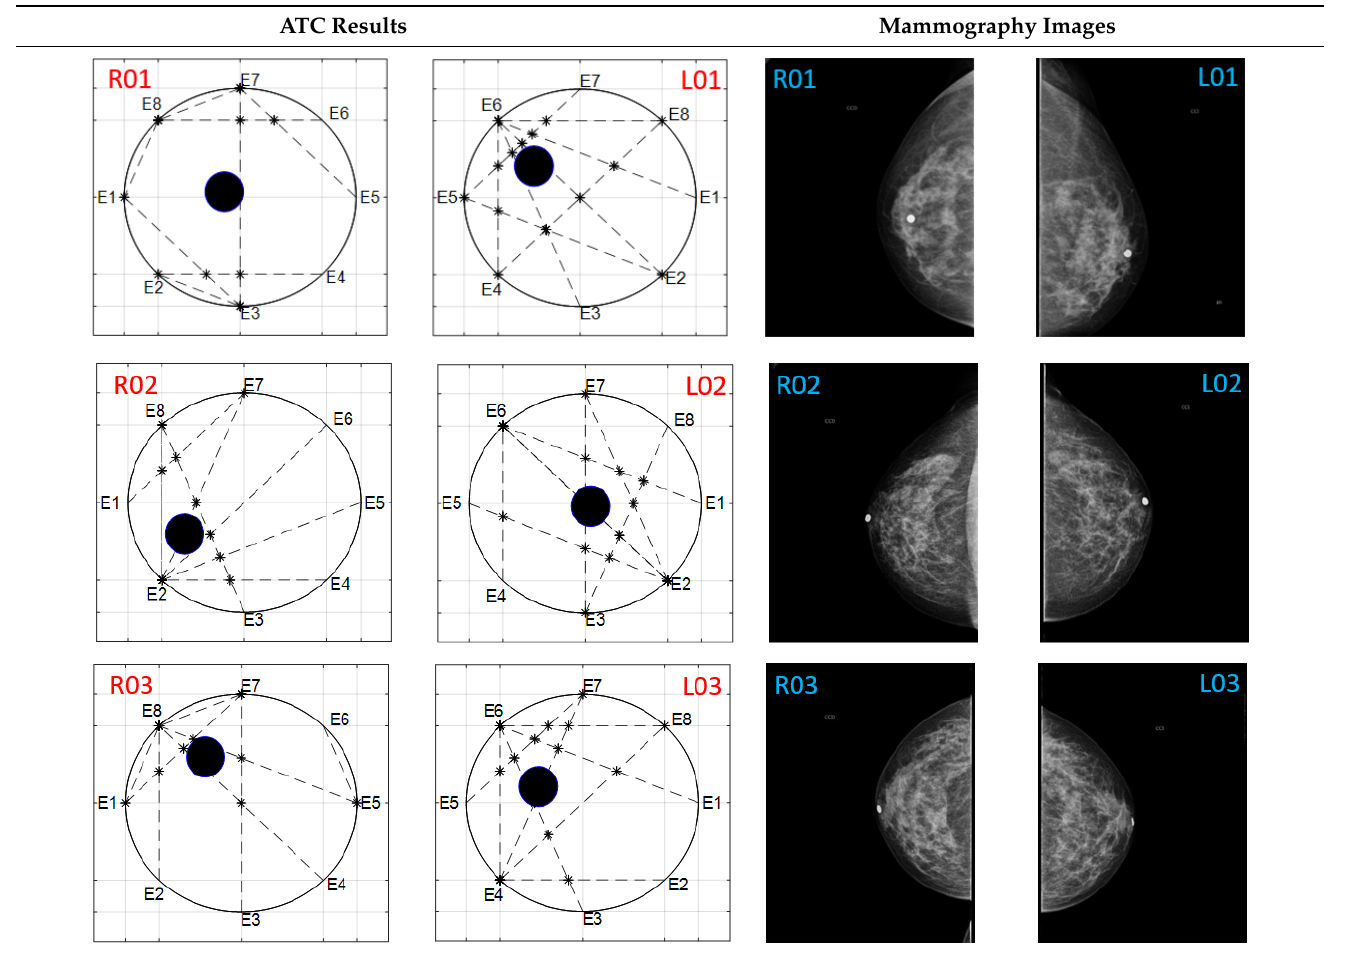
Table 3. ATC results and CC mammography images of each participant.